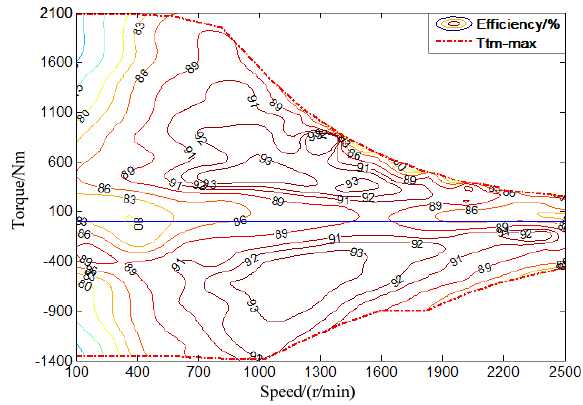
Figure 5. The ISG efficiency map.